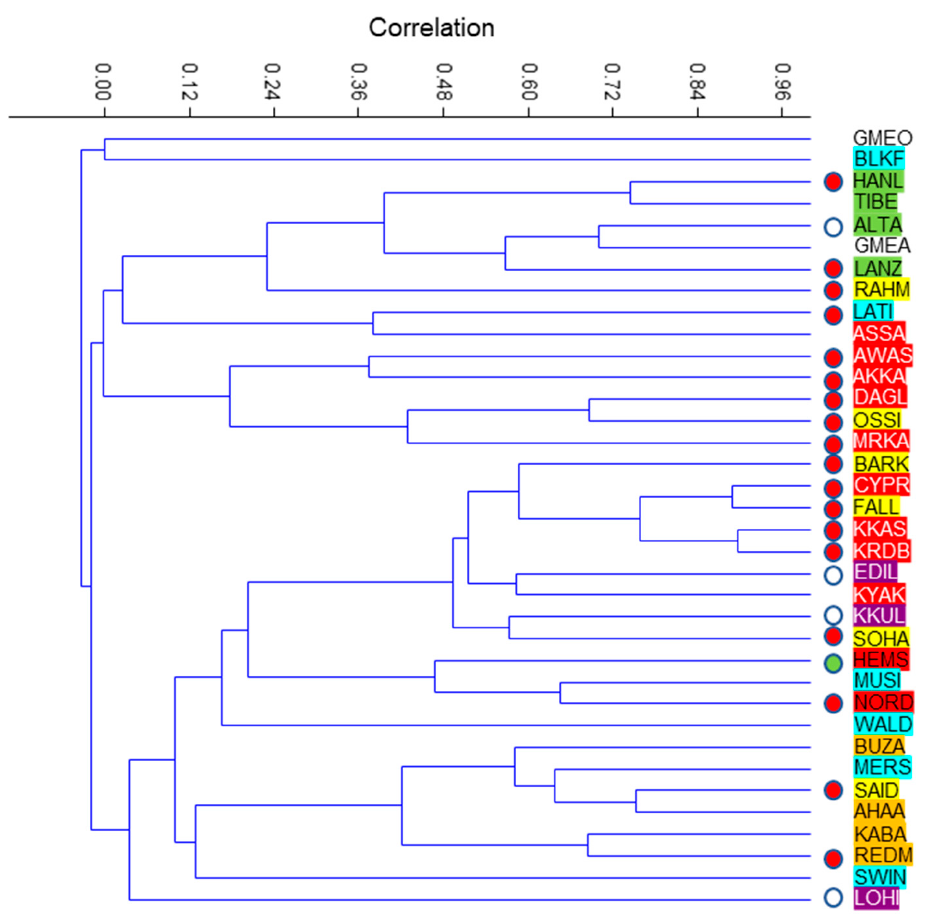
Figure 2. Cluster analysis from the phylogenetic analysis using Newick Extra according to the geographical distribution and tail phenotype. Wide circle: rumped tail; red circle: fat tail; green circle: fat deposit at the base of the tail; no circle: thin tail. Background color of characters: yellow: Egypt; orange: East Tropical Africa; blue: Europe; red: Western Asia; violet: Central Asia; green: Eastern Asia; white: O. gemlini anatolica and O. gmelini ophion . The breeds are noted according to the four-letter code in Table 1. The Tuj animal does not appear because it has no connection to any breed.